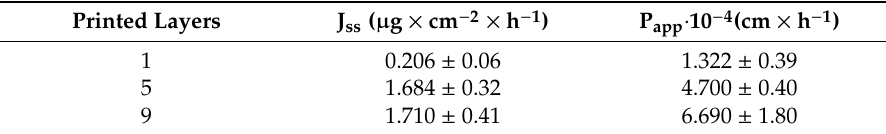
Figure 8. Cumulative transport of ( a ) THCl and ( b ) NA across the cellulose membrane. Table 4. Permeation parameters for THCl.